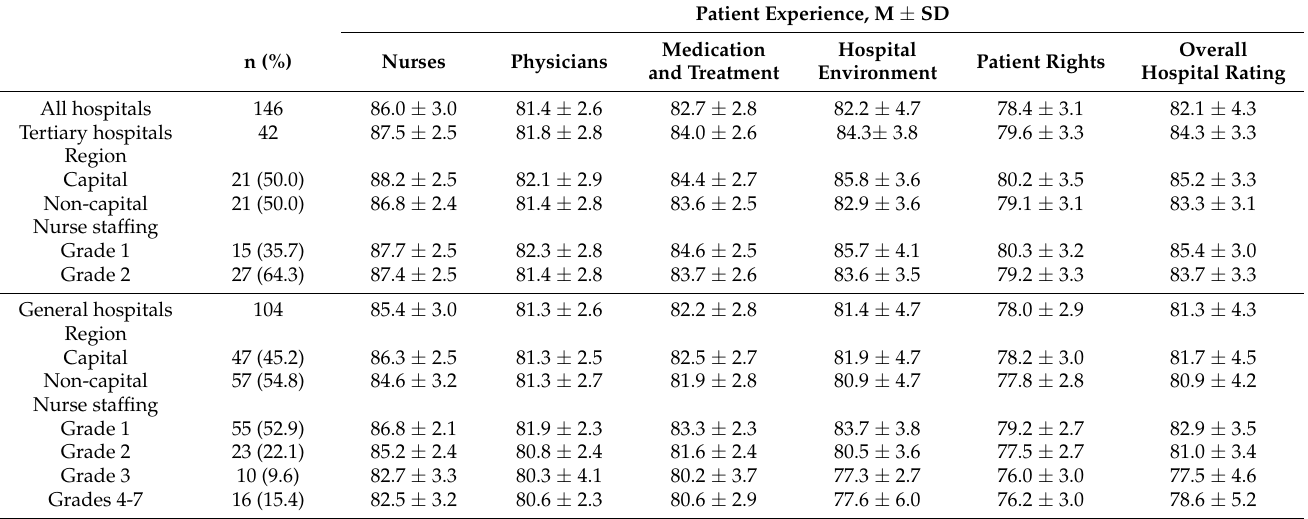
Table 1. Descriptive results of patient experience scores based on hospital